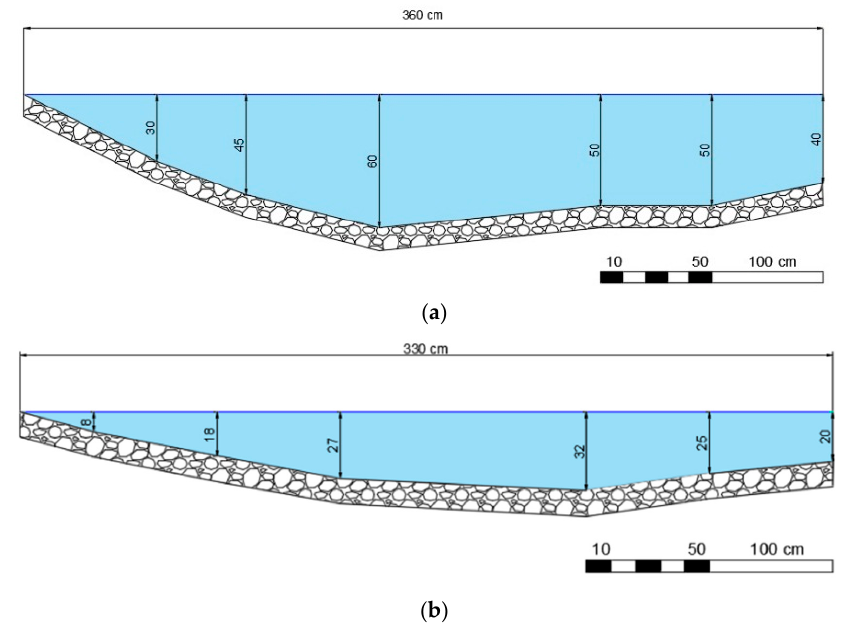
Figure 3. Section SW_01 set up at the May 2015 ( a ) and December 2015 ( b ) measurement campaigns.